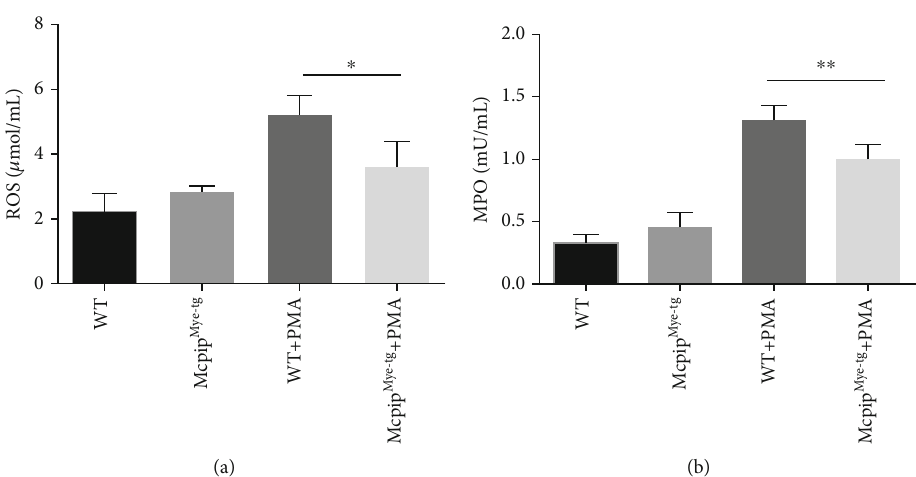
Figure 7: Overexpression of MCPIP-1 inhibits the production of ROS and MPO in neutrophils. Neutrophils ( 1 × 10 5 ) were isolated from the bone marrow of Mcpip Mye-tg ( n = 6 ) and WT ( n = 6 ) mice. The levels of ROS (a) and MPO (b) were measured by an Amplex Red Hydrogen Peroxide Assay Kit according to the manufacturer ’ s instructions after being stimulated in vitro with PMA (100ng/mL) for 3 hours. ∗ P < 0 : 05 and ∗∗ P < 0 : 01